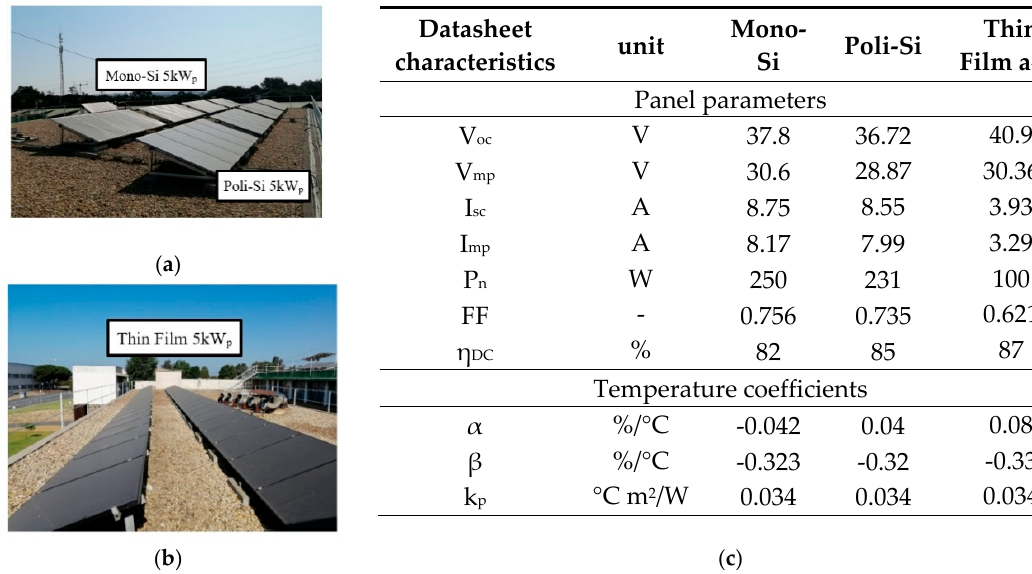
Figure 2. ( a , b ) Detail of the solar PV installation of microgrid shown in Figure 1; ( c ) PV panels datasheet characteristics.